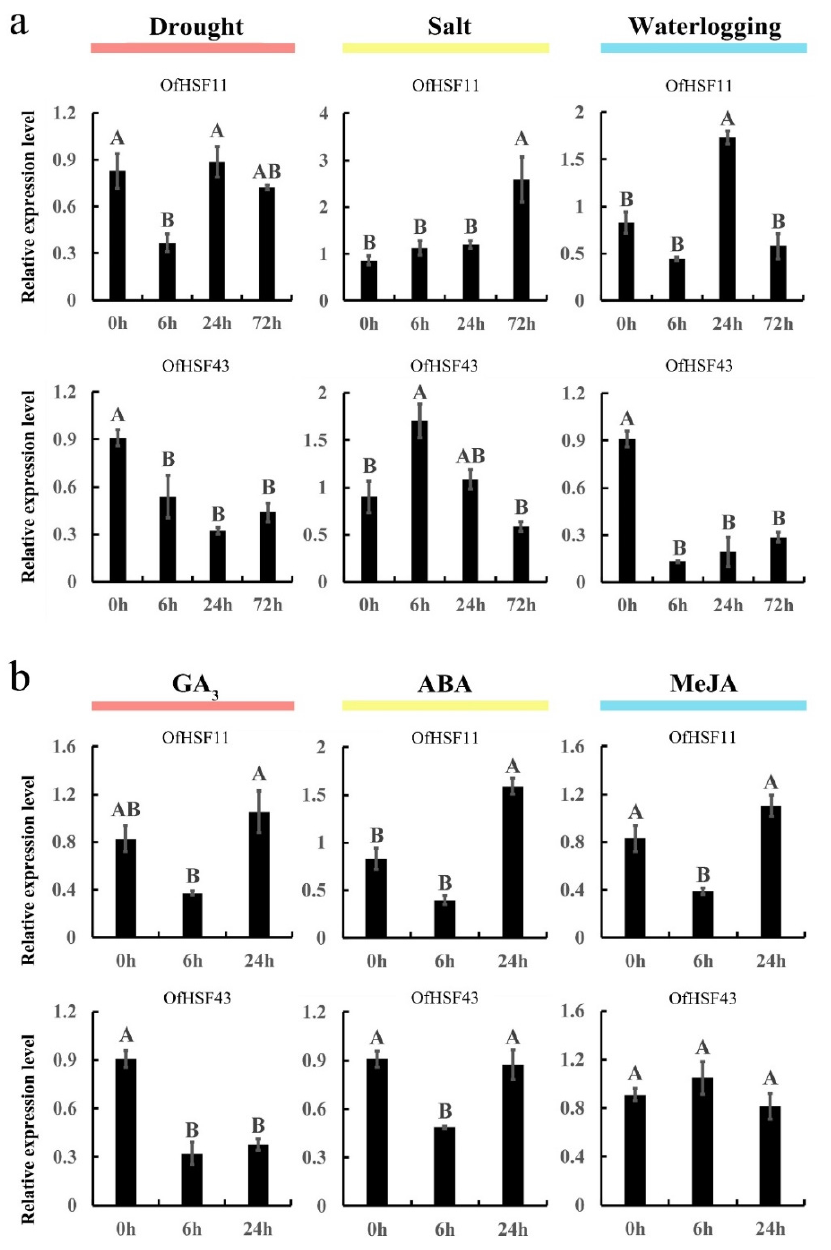
Figure 7. Expression patterns of OfHSF11 and OfHSF43 in response to multiple abiotic stresses ( a ) and exogenous hormonal treatments ( b ). The error bars indicate the means ± SEs ( n = 3). Capital letters represent the significant differences as assessed by Duncan’s test at the 0.01